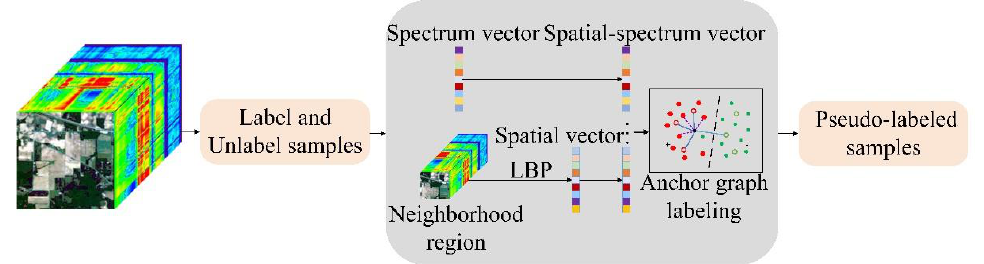
Figure 4. SS − RMG module of classification model.